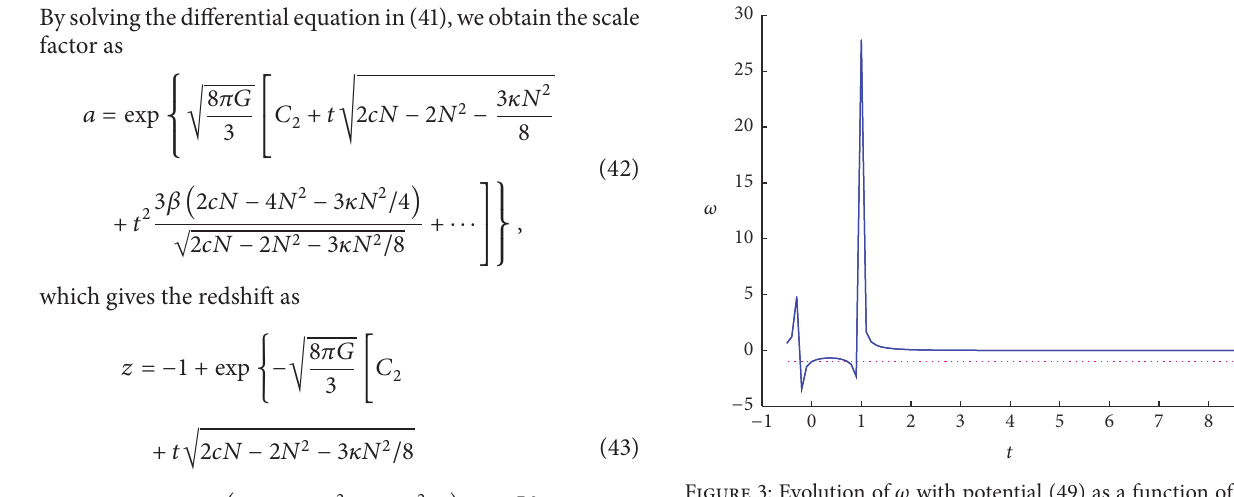
Figure 3: Evolution of 𝜔 with potential (49) as a function of time. For the numerical analysis we assume 𝑁 = 3 , 𝑐 = 3 , and 𝛽 = 1 . From